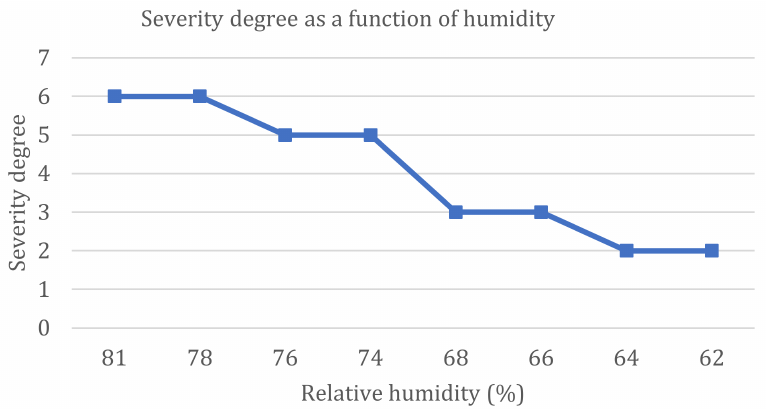
Figure 12. Severity degree as a function of humidity for the solid layer with the corresponding pollution for the month of